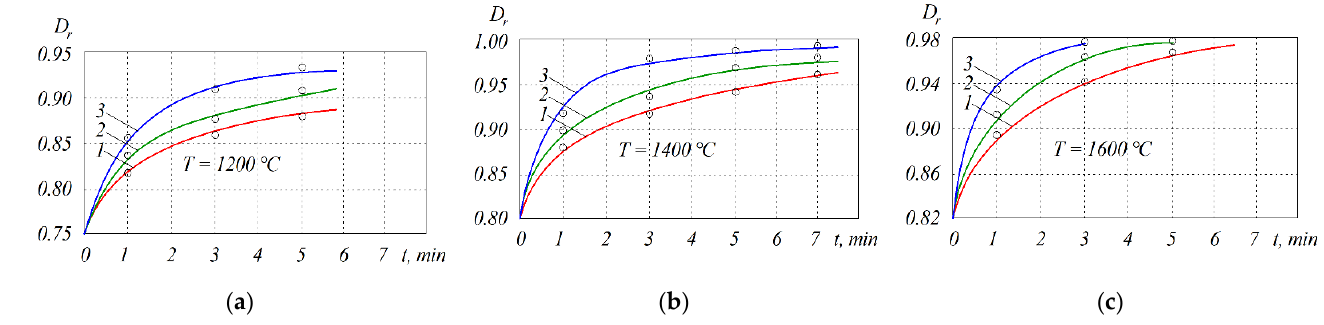
Figure 3. Interpolated curves of relative density D r of the Cr 2 O 3 + (Cr,Al) 2 O 3 + 22 wt.% Cr cermets sintered at different temperatures: ( a ) T = 1200 °С; ( b ) T = 1400 °С; ( c ) T = 1600 °С. Plots are denoted as follows: 1 — P = 15 MPa; 2 — P = 22 MPa; 3 — P = 30 MPa.